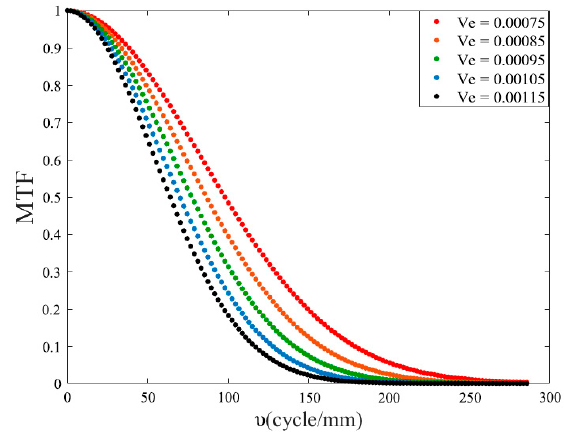
Figure 7. MTF curves at different error velocities.